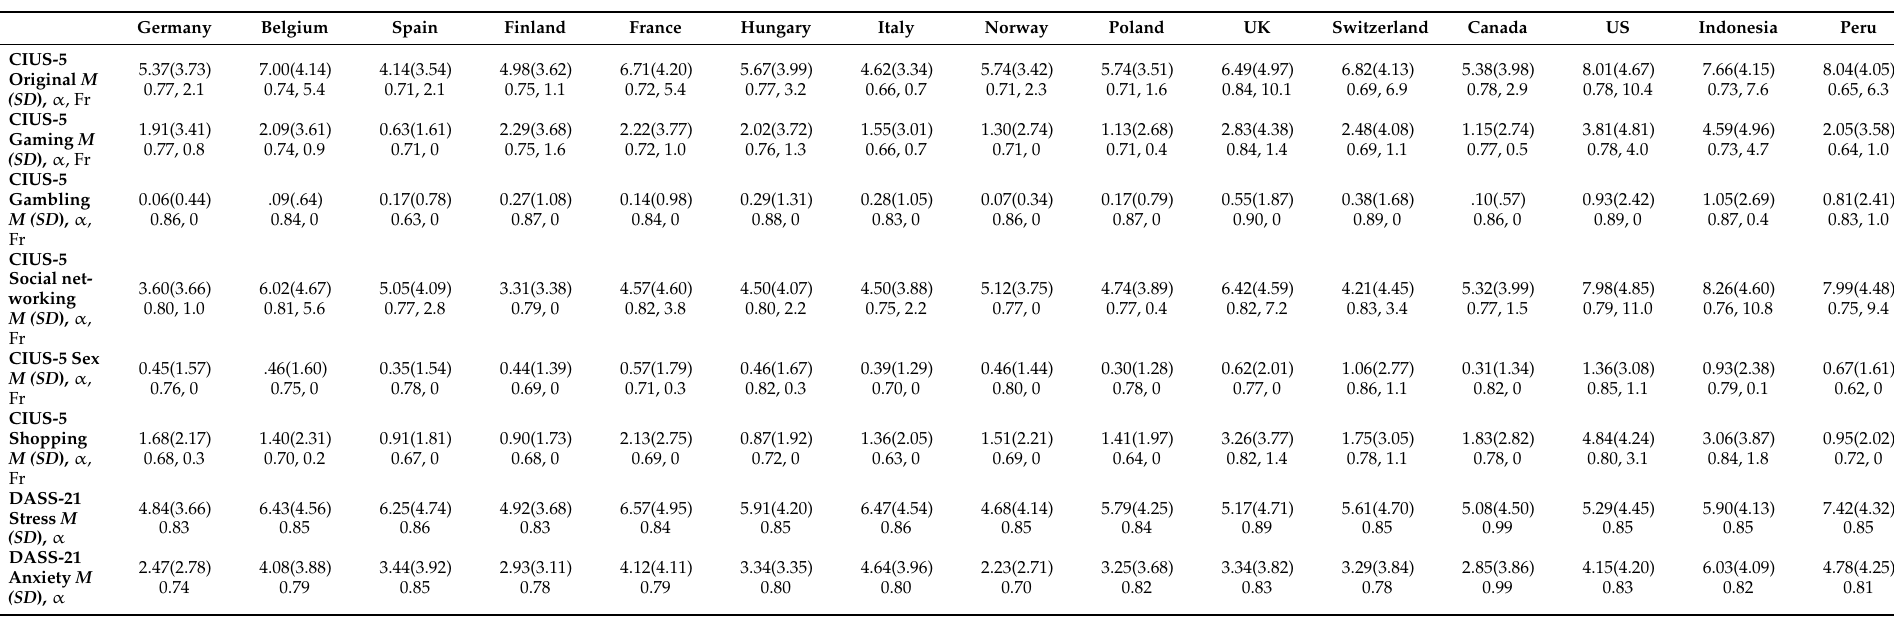
Table 3. Descriptive statistics and reliability of problematic internet use and psychopathology and personality measures from fifteen